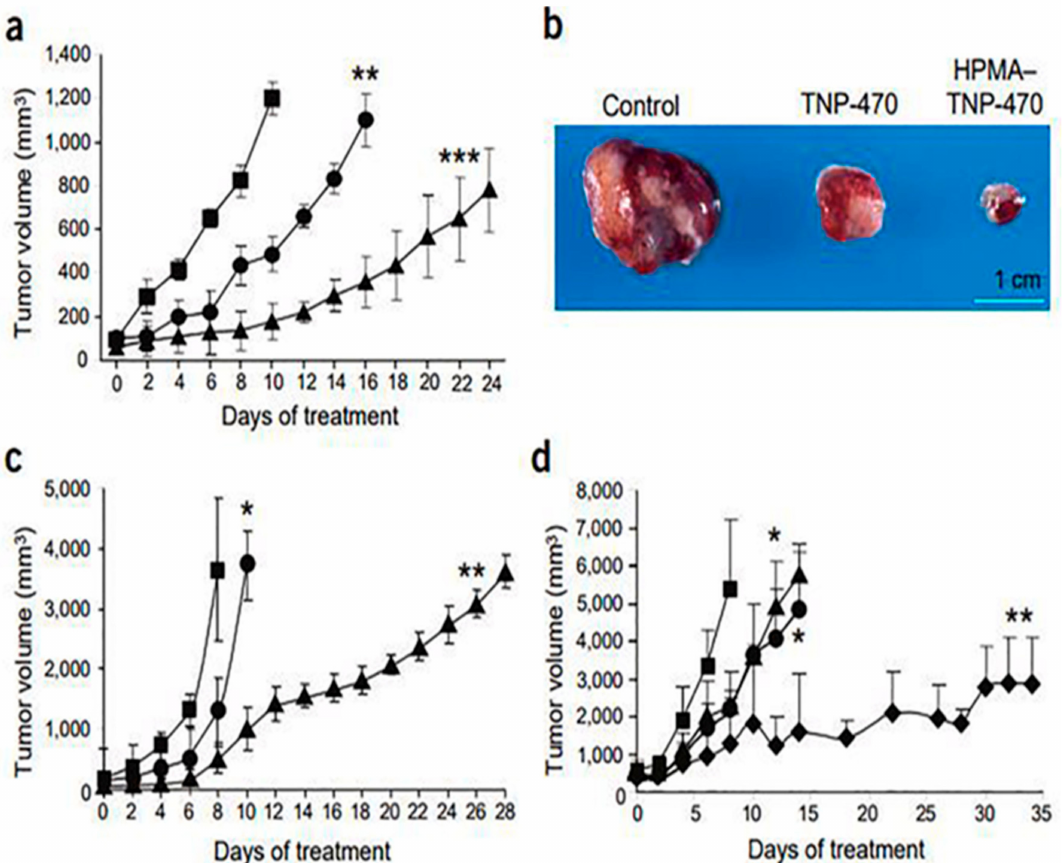
Figure 4. HPMA copolymerTNP-470 inhibitsA2058 human melanoma and LLC growth. ( a ) E ff ects of TNP-470 ( (cid:8) ), HPMA copolymerTNP-470 conjugate ( (cid:78) ) and saline ( (cid:110) ) on male SCID mice bearing A2058 human melanoma ( n = 5 mice per group). ( b ) Excised tumors (from (a)) on day 8 of treatment. ( c ) E ff ects of TNP-470 (30 mg / kg q.o.d. s.c.; (cid:8) ) and HPMA copolymerTNP-470 (30 mg / kg q.o.d. s.c.; (cid:78) ) on C57 mice bearing LLC tumors and untreated control mice ( (cid:110) ); n = 10 mice per group). ( d ) Dose escalation of HPMA copolymerTNP-470 inC57 mice bearing LLC tumors. Data at 30 ( (cid:78) ), 60 ( (cid:8) ), and 90 mg / kg q.o.d. ( (cid:7) ) and controls ( (cid:110) ) are shown ( n = 5 mice per group). All data represent mean ± s.e. * p < 0.05; ** p < 0.03; *** p < 0.01 compared with control [102]. Reproduced with permission from [102]. Copyright, 2004,